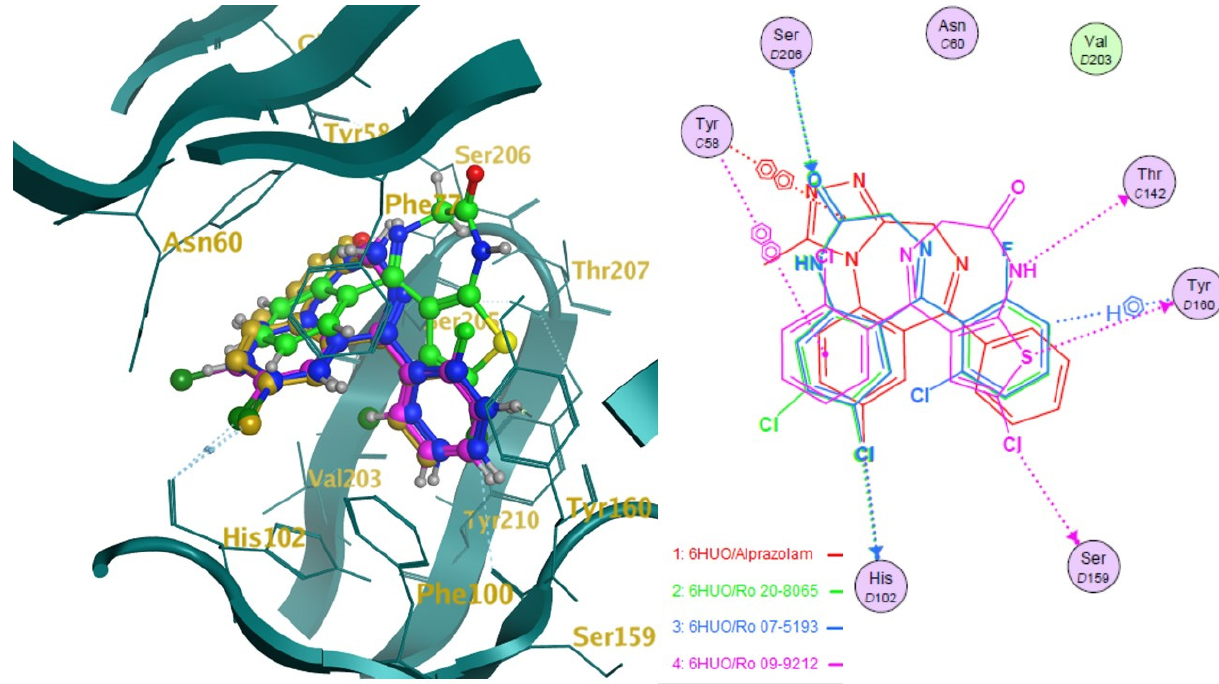
Figure 5. Docking studies on 6HUO [61] binding pocket. Notes: on the left side, the 3D representation of the molecules (Ro 09-9212, Ro 07-5193, Ro 20-8865) docked on the co-crystallised ligand (alprazolam in gold). On the right side is the 2D representation of the ligands’ interactions with the residues of the binding pockets. The dotted lines indicate a hydrogen bond (donor or acceptor according to the direction of the arrow at the end of it) between the ligand and the pocket residues; the dotted lines showing the H and benzene symbol indicate an arene-hydrogen interaction, while the ones showing the two benzene symbolise an arene-arene interaction.